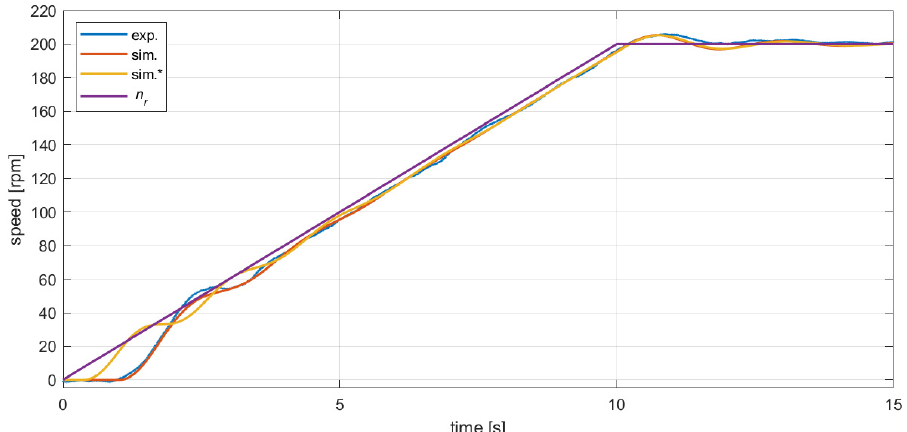
Figure 17. Measurement and result of simulation of the waveform of speed on the motor n s for the control system ( K P = 0.02, T I = 0.5 s ) . Waveforms labelled “sim.” and “sim.*” shows the difference between simulation results with and without the modified spool valve model (Equation (4)).